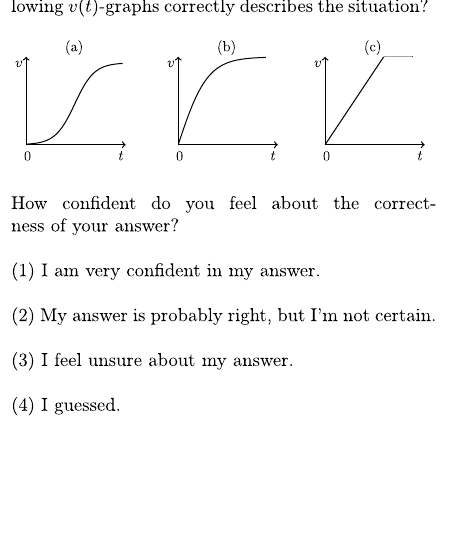
FIG. 2. Two example KiRC items: Multiple choice item in graphical representation format about free fall with air resistance presenting three alternatives and a confidence rating scale (left), and multiple true-false items dealing with the concept of frame of reference